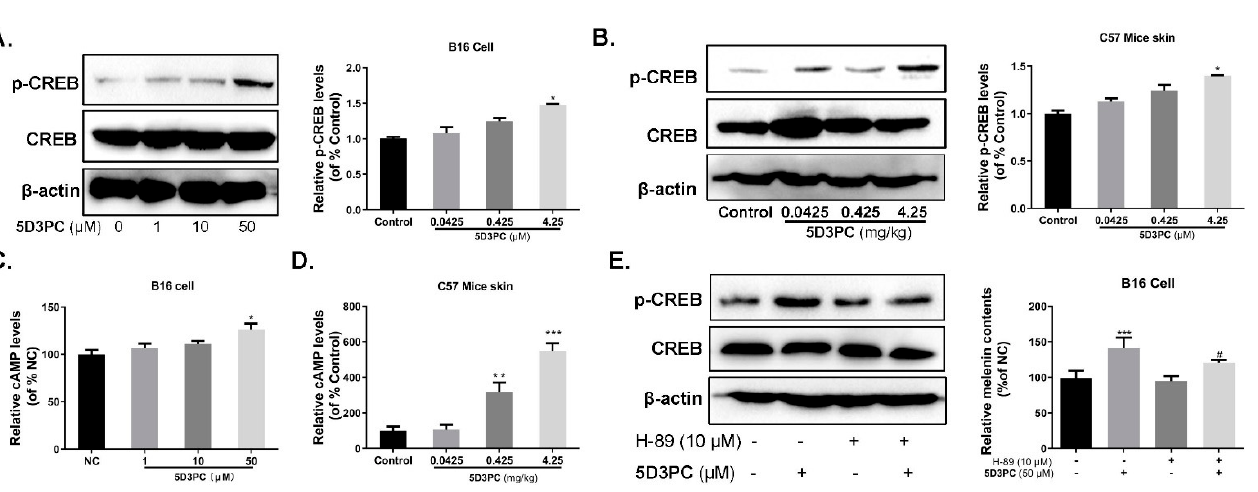
Figure 5. 5D3PC induces melanogenesis by activating the cAMP/PKA signal pathway. ( A ) The levels of p-CREB in B16 cells were determined by WB analysis. ( B ) the levels of p-CREB after being treated with 5D3PC in C57BL/6 mouse model. p-CREB proteins were analyzed relative to β -actin expression. ( C ) B16-intracellular cAMP levels and ( D ) C57BL/6 mouse skin-cAMP levels were analyzed using a cAMP assay ELISA kit. ( E ) 5D3PC-induced melanin synthesis and p-CREB expression were blocked by PKA inhibitors in B16 cells. All results are expressed as mean ± SD; statistical analysis was performed with one-way ANOVA, followed by Tukey’s multiple comparisons test. # p < 0.05,* p < 0.05, ** p < 0.01, and *** p < 0.001 compared with NC (negative control)